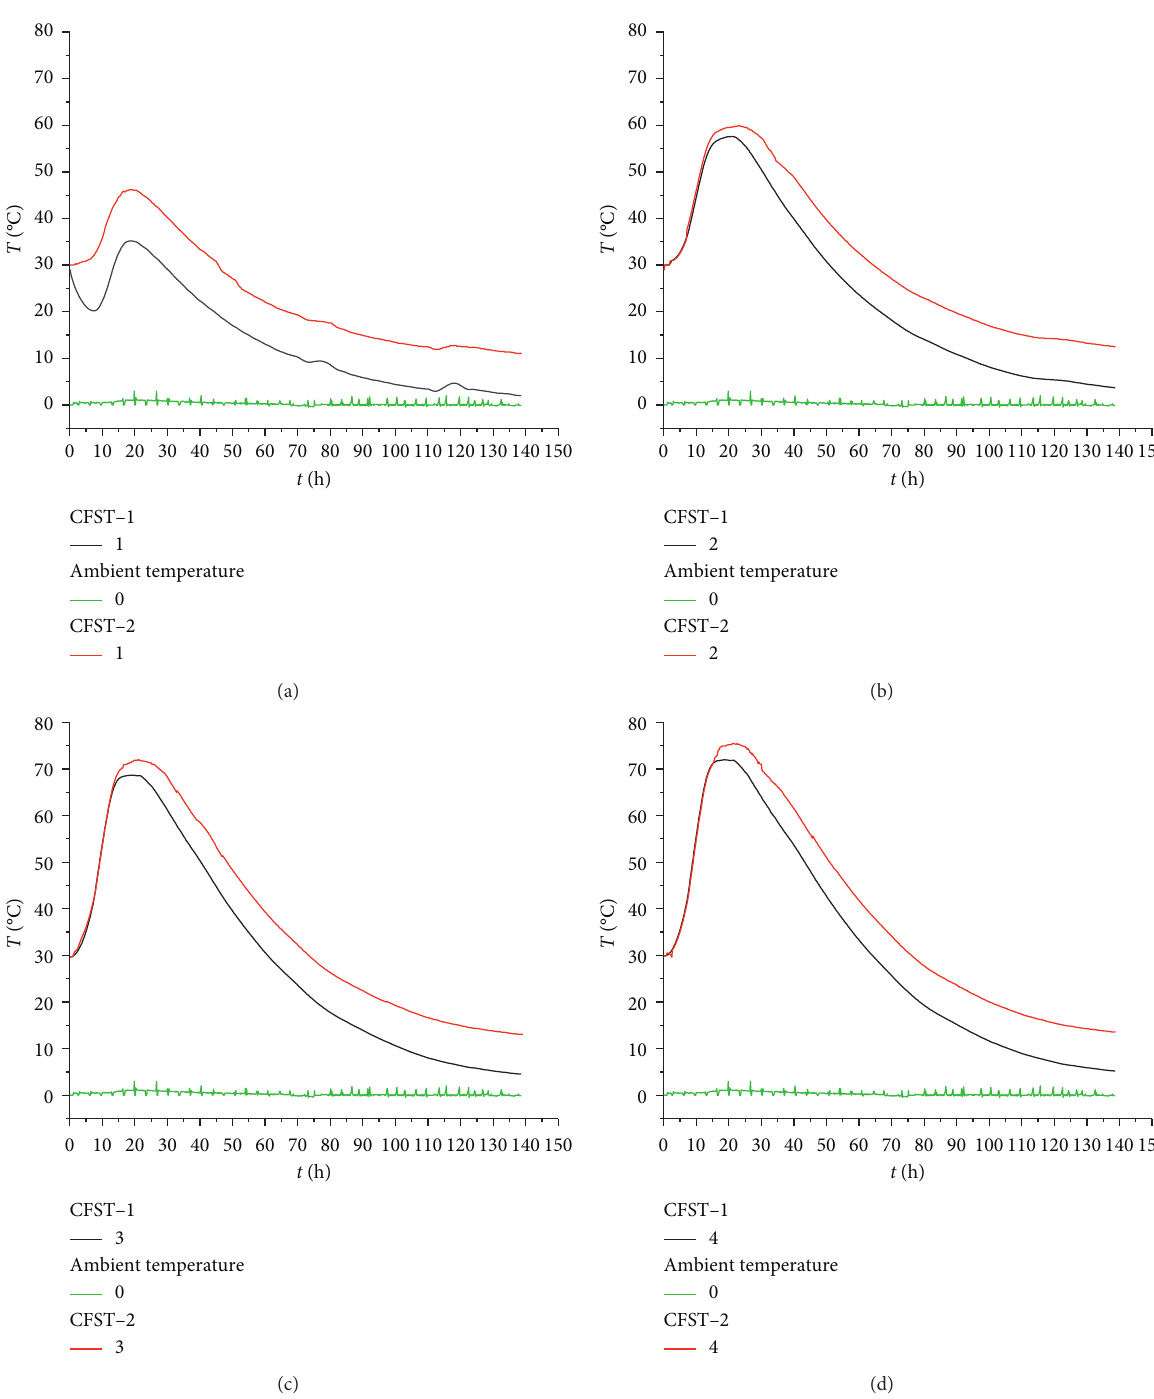
Figure 12: Hydration heat vs time for in-pipe concrete. (a) Point 1. (b) Point 2. (c) Point 3. (d) Point